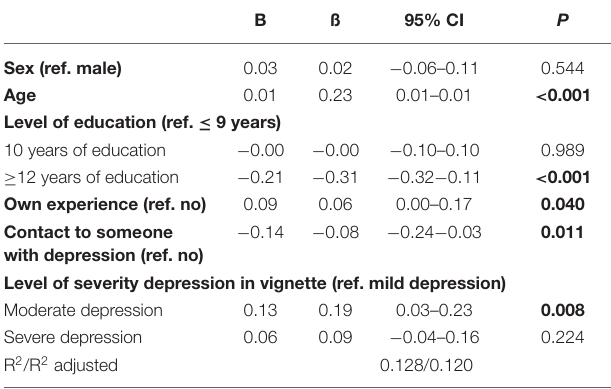
TABLE 4 | Multiple linear regression, sociodemographic characteristics, personal TABLE 3 | Multiple linear regression, sociodemographic characteristics, personal experience, and level of severity regressed on “Perceived Fundamental Difference” experience, and level of severity regressed on “Continuum Belief” ( N = 985). ( N = B ß 95% CI